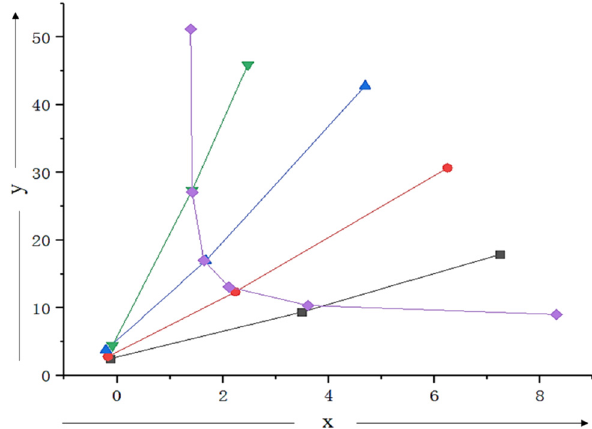
Figure 6: Change of heading angle under the dynamic positioning